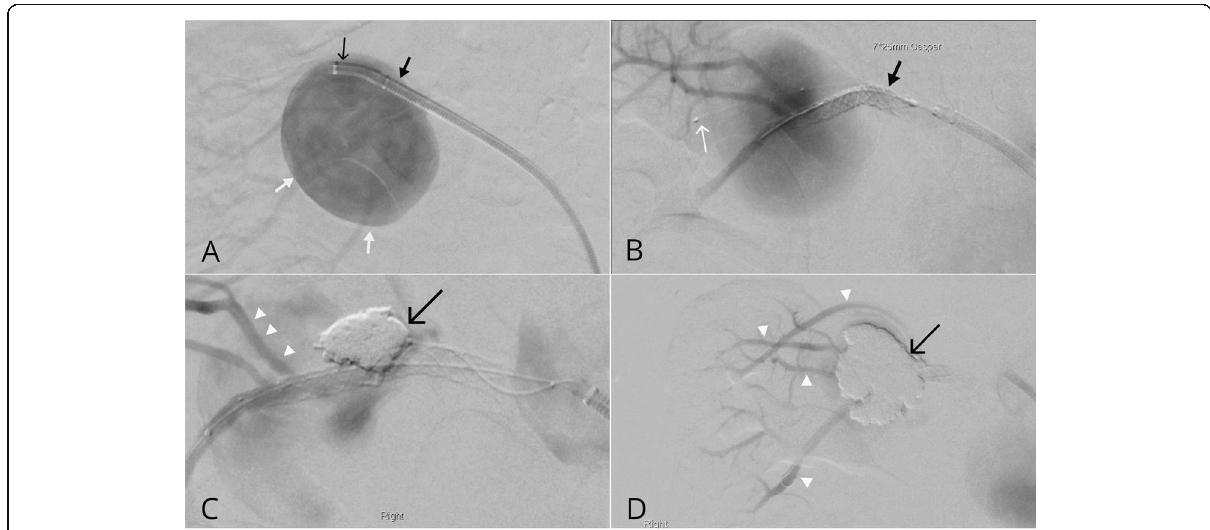
Fig. 4 Combined CASPER stenting and Onyx embolisation. a A large right renal artery aneurysm (white arrows) was accessed with a guidesheath (thick black arrow) and inner diagnostic catheter (thin black arrow). b With the guidecatheter retracted proximally) a 7 × 25 mm CASPER stent (black arrow) was subsequently deployed over the aneurysm neck with a Rebar-14 microcatheter (white arrow) jailed within the aneurysm. Note mild contrast stasis. c A significant inflow jet was observed and as such a small volume of Onyx HD 500 (black arrow) was slowly injected to promote thrombosis. c and d Note all the segmental renal artery branches remained patent with near complete stasis and occlusion observed